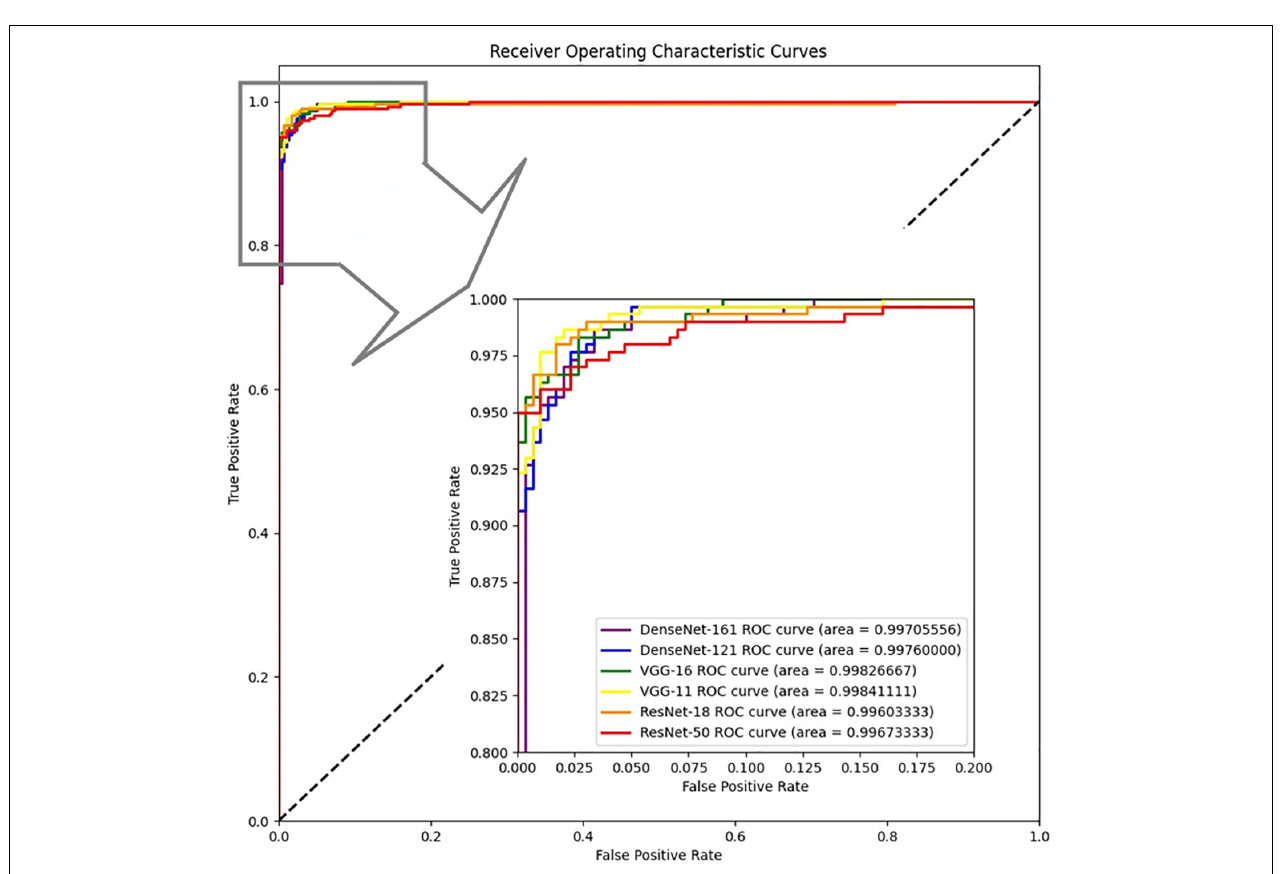
FIGURE 7 | ROCs of the proposed network with different backbones: ResNet-18, ResNet-50, VGG-11, VGG-16, DenseNet-121, and DenseNet-161.